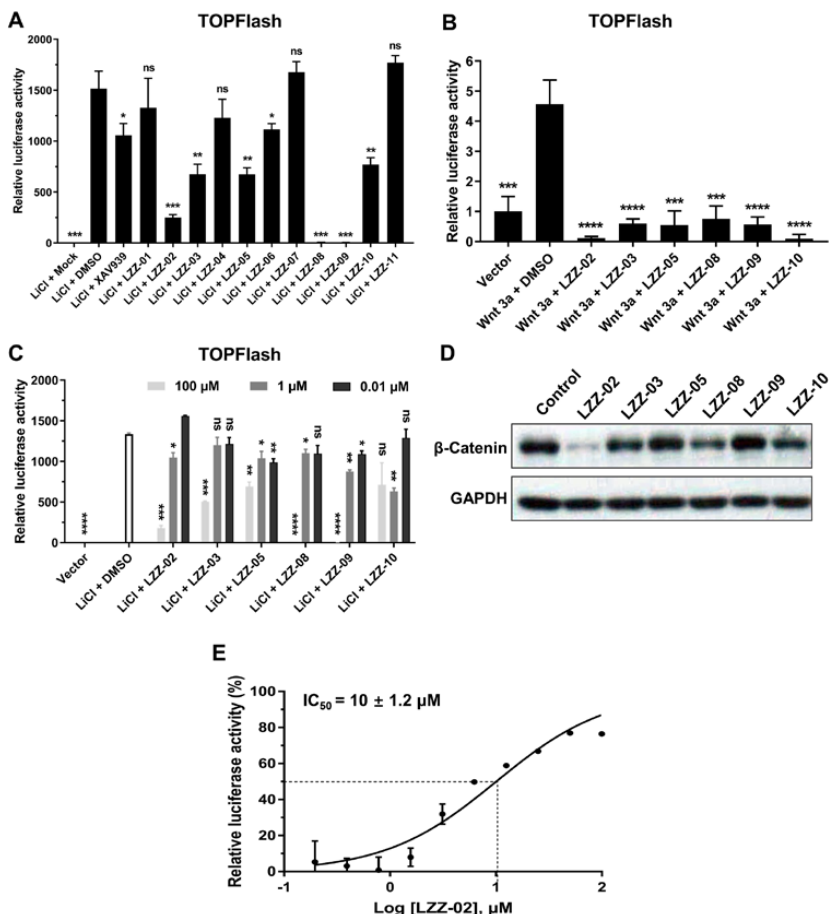
Figure 3. Evaluation of hits as tankyrase inhibitors. ( A ): Biological screening of candidates. HEK293 cells (1 × 10 5 ) were transfected with the indicated reporter plasmid (0.1 μg) and then further treated with the indicated candidates’ compounds (100 μM) and LiCl for 24 h before luciferase assays were performed. ( B ): The compounds inhibit WNT 3a-induced TOPFlash activity. HEK293 cells (1 × 10 5 ) were transfected with the indicated reporter plasmid (0.1 μg). Cells were then left untreated or treated with the indicated candidates’ compounds (100 μM) and Wnt 3a for 24 h before luciferase assays were performed. ( C ): The experiments were similarly performed as in (A), LZZ-02 inhibited LiCl-upregulated TOPFlash activity in dose-dependent. ( D ): Effects of the candidates’ compounds on β -catenin expression in DLD1 cells. DLD1 (2 × 10 6 ) cells were left untreated or treated with indicated compounds (100 μM). Cell lysates were analyzed by immunoblots with the indicated antibodies. ( E ): Transfected cells treated with LZZ-02 at indicated concentration. Data are presented as mean (n = 3) ± SD, ns: non-significant, *P < 0.05, **P < 0.01, ***P < 0.001, ****P < 0.0001.